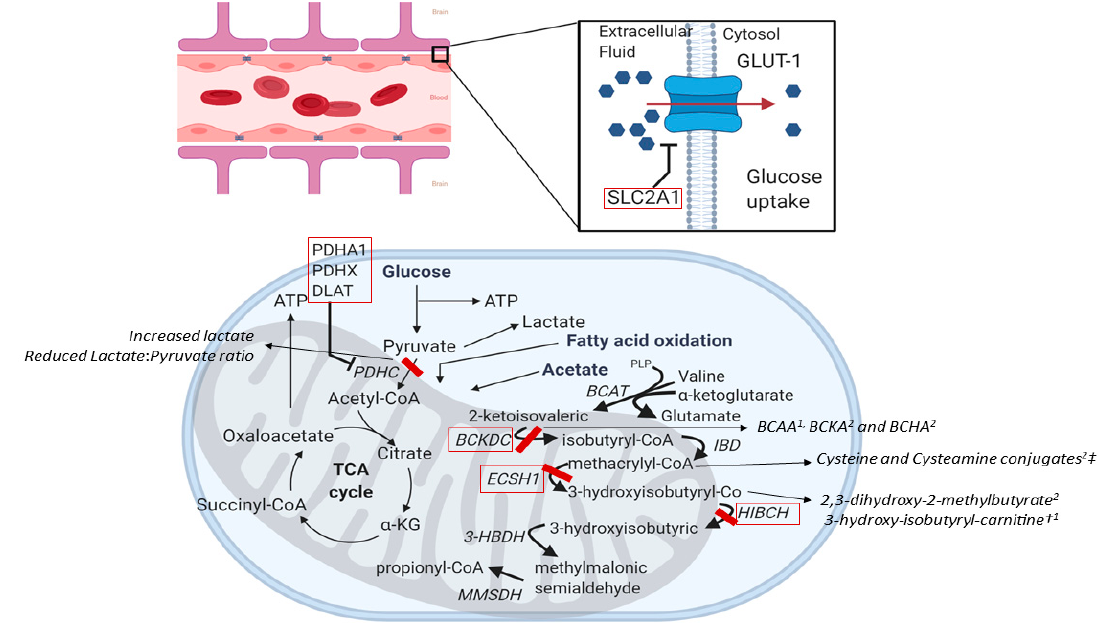
Figure 4. Molecular mechanisms causing brain energy failure and mitochondrial dysfunction in PMDs. Red rectangles indicate genes involved in PMDs. Expression and function of GLUT-1 on membrane surface of endothelial cells of the brain vasculature is illustrated on the top. Mitochondrial energy production and BCAA (leucine, isoleucine, and valine) catabolism are illustrated on the bottom. PDHC converts pyruvate into acetyl-CoA, regulating its entry into the tricarboxylic acid (TCA) cycle and the activity of the oxidative phosphorylation. PDHC deficiency decreases the availability of acetyl-CoA for the TCA cycle promoting the reduction of pyruvate to lactate, determining intracellular energy failure and impaired redox state. Metabolic defects in BCAA